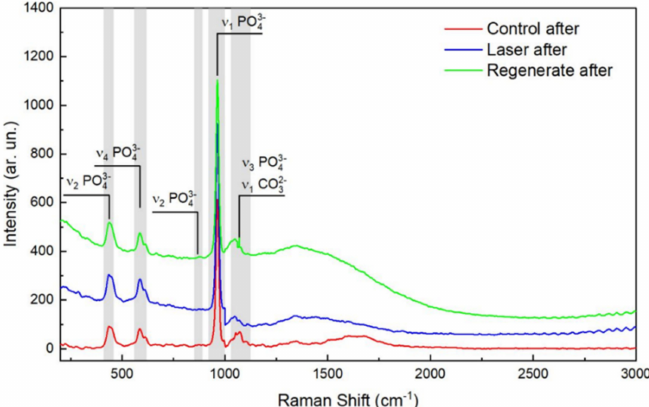
Figure 3. Representative Raman spectra of the control, Regenerate-treated group, and those treated with CO 2 laser after pH-cycling. The vibrational peak of ν 1 PO at 960 cm − 1 is the strongest signal of all Raman spectra and is highest in the Regenerate group, followed by the laser-treated group, while the control group has the lowest peak intensity of all groups. The carbonate at 1070 cm − 1 is strongest in the regenerate